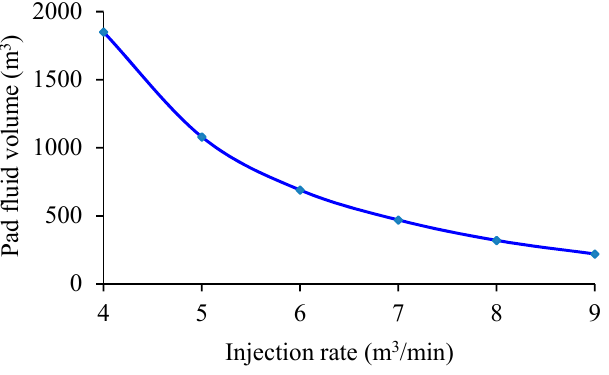
Figure 10. Curve describing the relationship between pad fluid volume and injection rate.